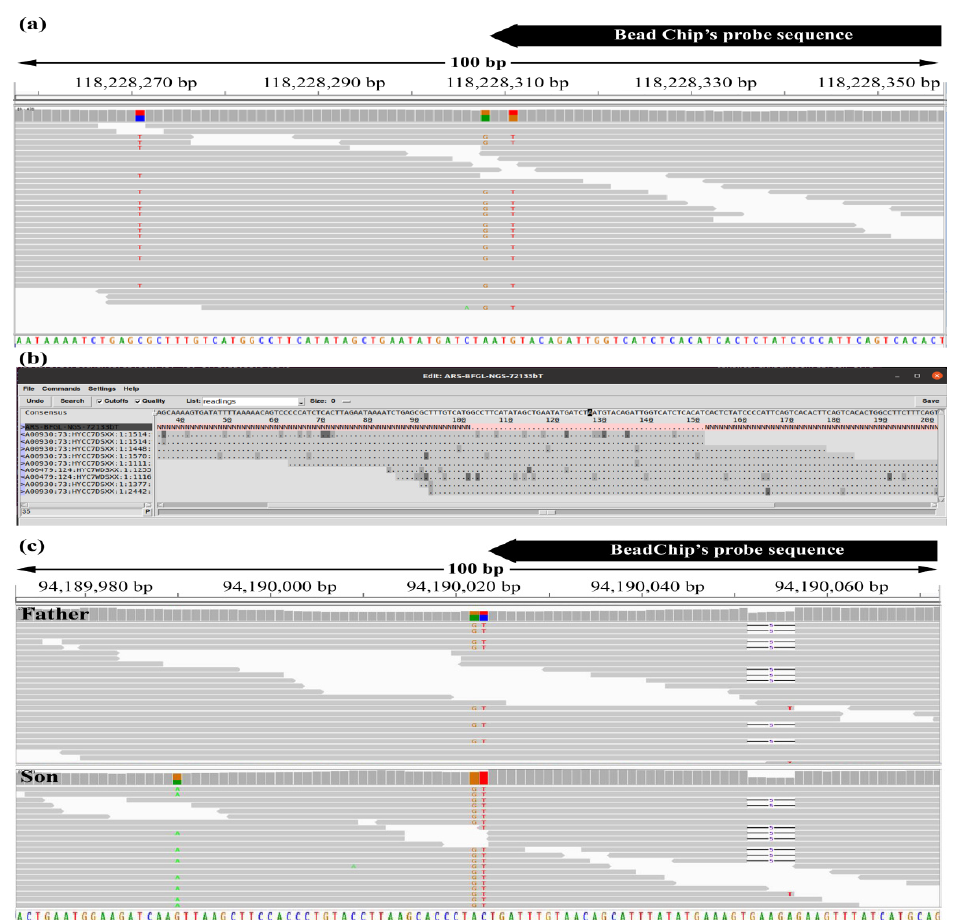
Figure 1. Output of the assembly visualizers for SNPs ARS-BFGL-NGS-72133 and BTB-01793064. Position 118,228,308 on BTA1 of sire 7424 genome was examined. ( a ) An IGV output. Using the VCF method, this SNP was genotyped as heterozygous with 17 and 13 reads of A and of G alleles, respectively, whereas the BeadChip and GAP5 genotypes were AA homozygous. ( b ) GAP5 output with 9 reads of the A allele. Pink background denotes the template with 50 bp spanning the SNP site (black background on the consensus line). Bases identical to the consensus sequence are denoted as dots with background color that corresponds to the quality score, with light gray indicating higher quality. ( c ) Position 94,190,023 on BTA1 of father and son (7396 and 7851, respectively) genomes were examined. Using the VCF method, the father’s SNP was genotyped as heterozygous with 12 and 7 reads of C and of T alleles, respectively, whereas the son was homozygous for the T allele (19 reads).